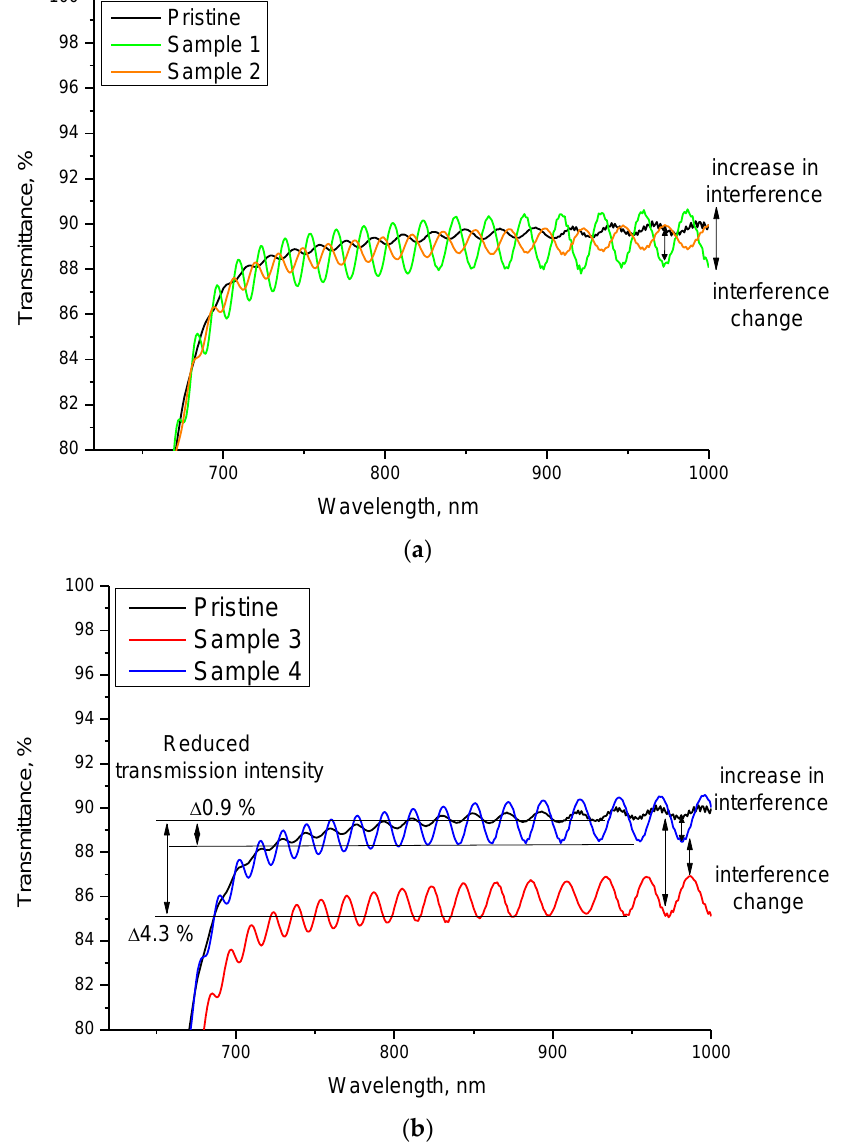
Figure 2. Transmittance results of the studied samples: ( a ) residential premises; ( b )